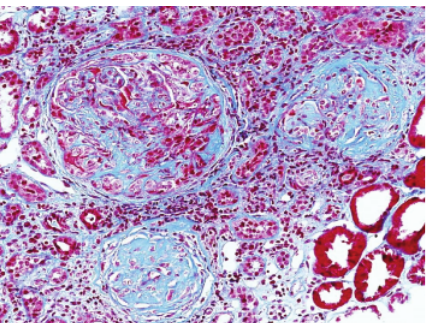
Figure 2: Case 2. Oneglomerulus with fibrocellular crescent (upper left), two glomeruli with global sclerosis, interstitial inflammation with marked interstitial fibrosis, and tubular atrophy. Masson trichrome, 100x